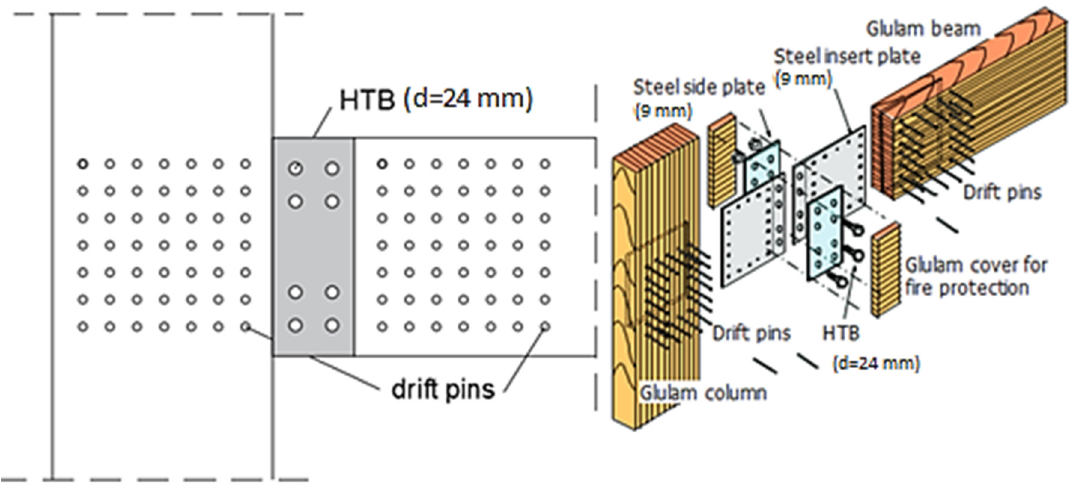
Figure 3. Drift-pin joints with insert-type steel plate (Adapted from Ref. [22]).